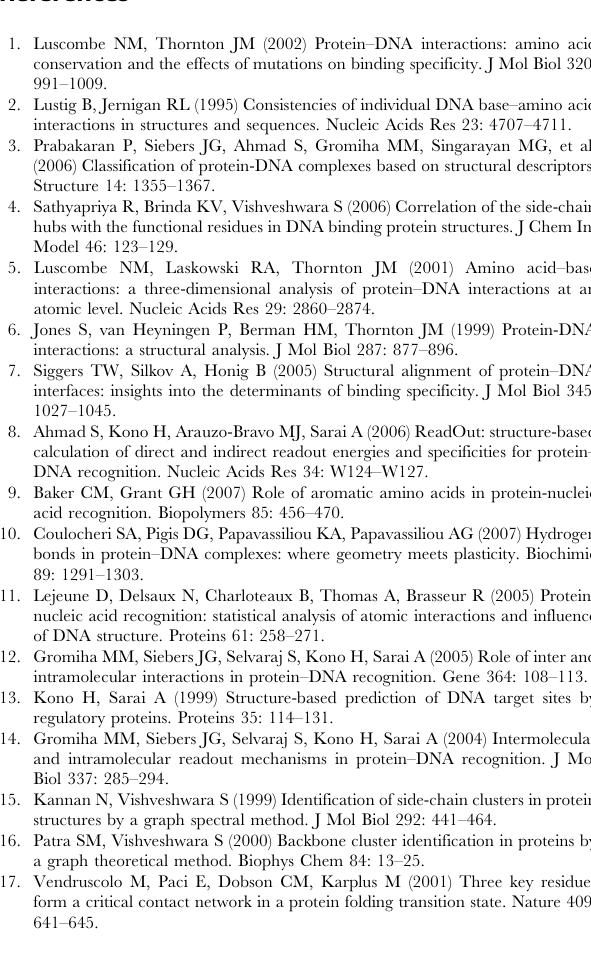
Table S5 Normalization values evaluated from the updated dataset